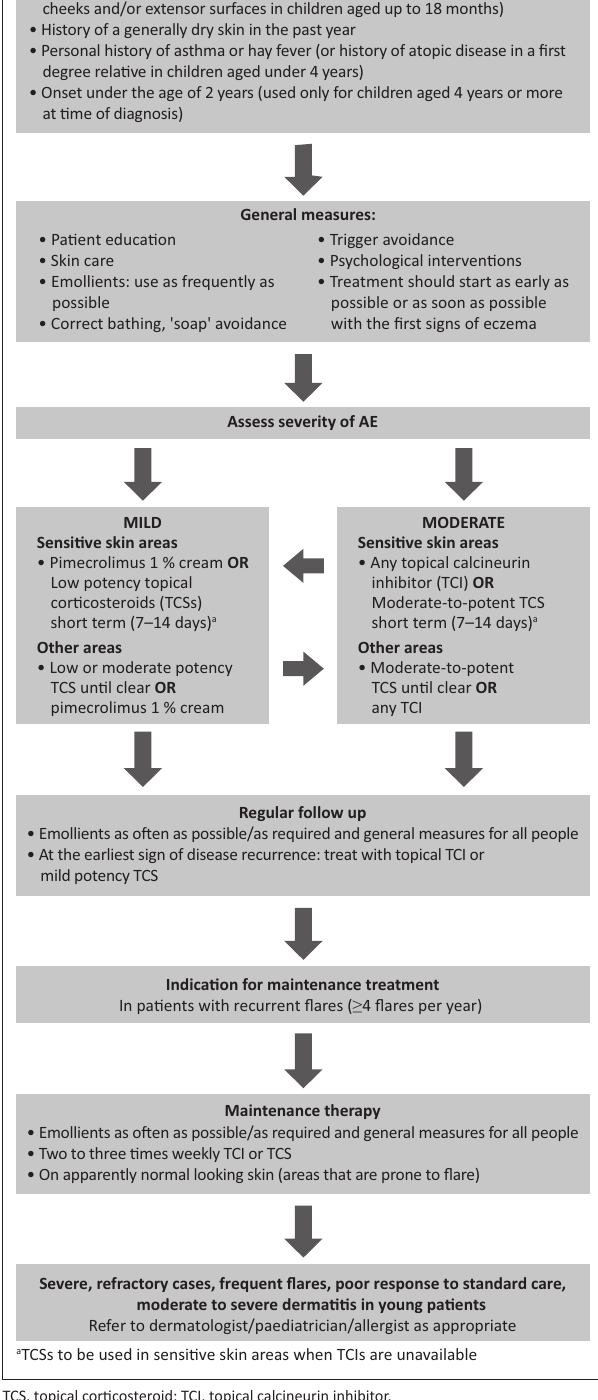
FIGURE 1: Treatment algorithm for paediatric patients with atopic eczema (AE; atopic dermatitis) in South